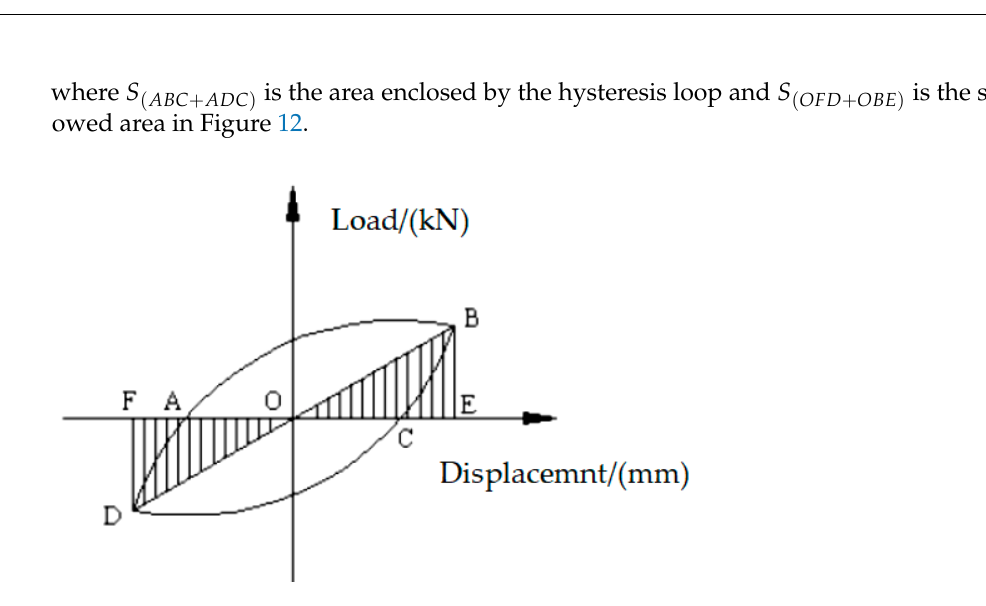
Figure 12. The sketch map of the dissipative ratio.